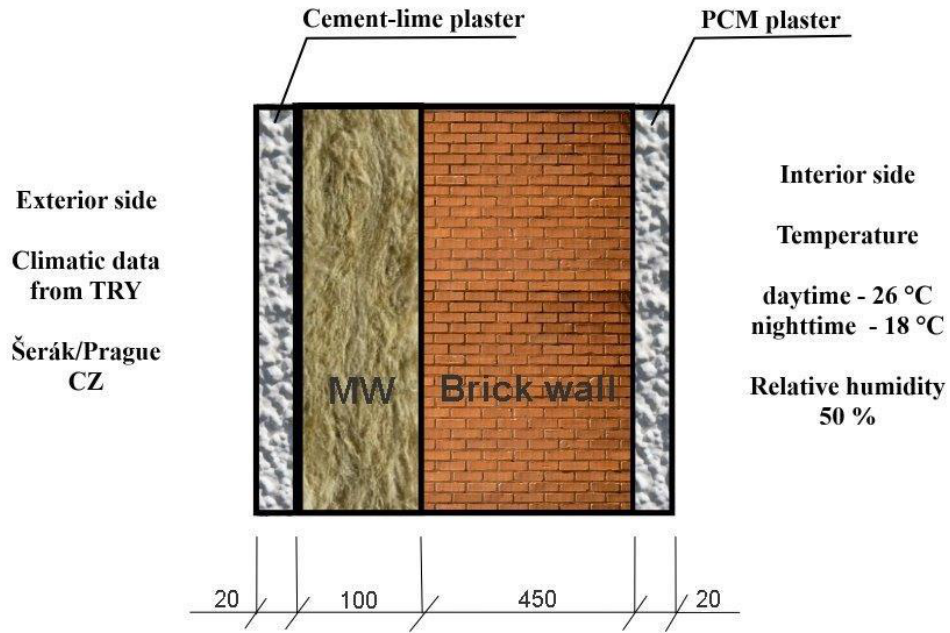
Figure 1. Scheme of computational simulation for brick / mineral wool construction.